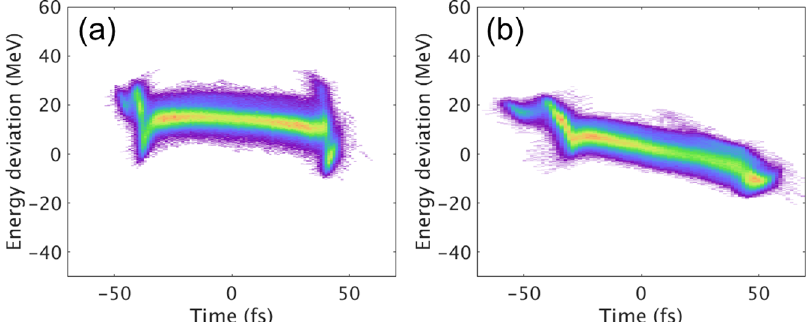
FIG. 8. The final phase space of the collimated beam at the entrance of the undulator with different setting of the beam current after BC1: (a) 130 A; (b) 180 A. The final beam energy at the undulator entrance is 4 GeV, with current about 1500 A. The bunch head is to the left.